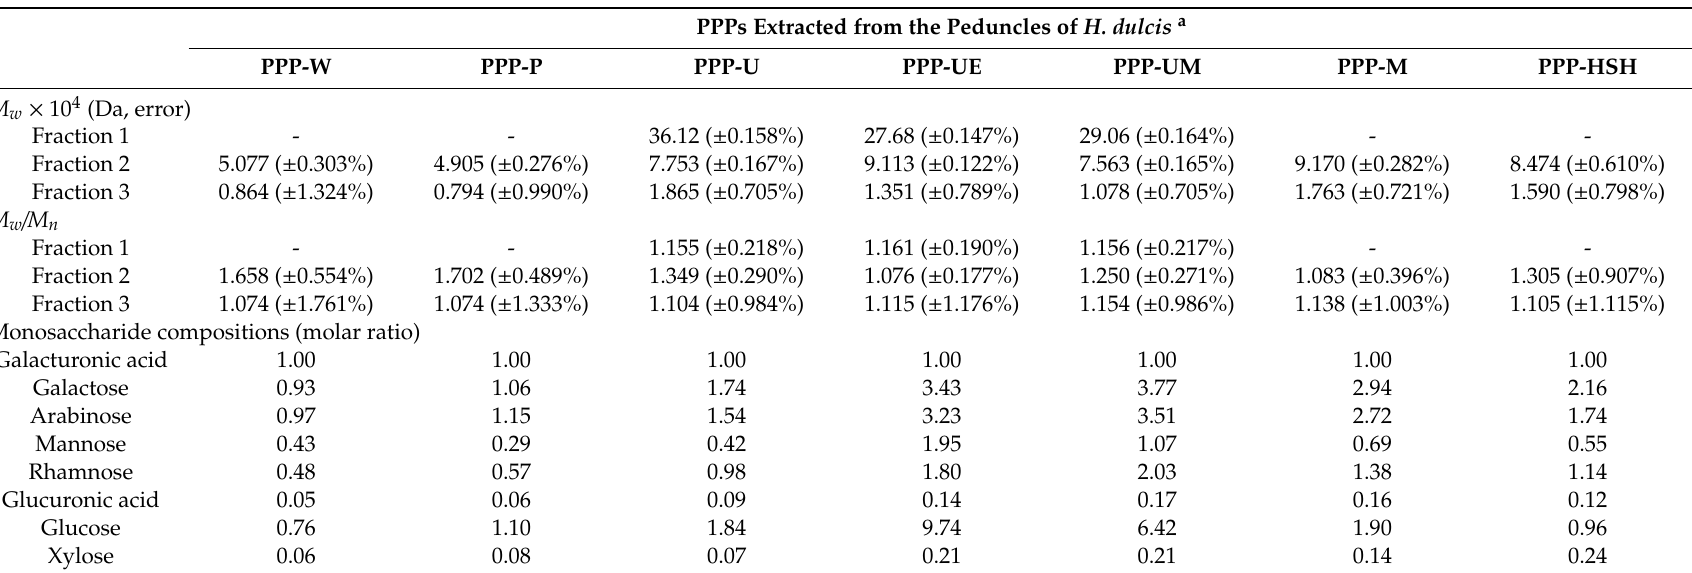
Table 2. Molecular weight ( M w ), polydispersity ( M w / M n ), and monosaccharide composition of PPPs obtained by seven extraction methods. PPPs Extracted from the Peduncles of H. dulcis